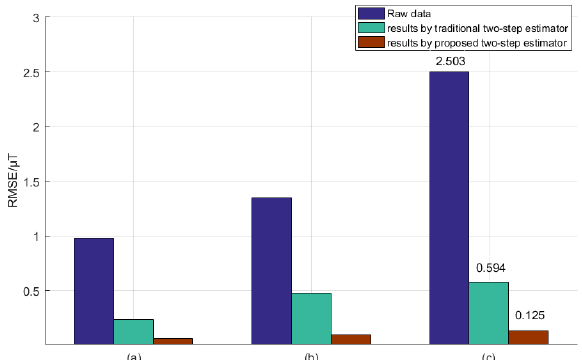
Figure 8. The comparison of RMSE. ( a ) the interference source radius is 90 cm; ( b ) the interference source radius is 70 cm; ( c ) the interference source radius is 50 cm.